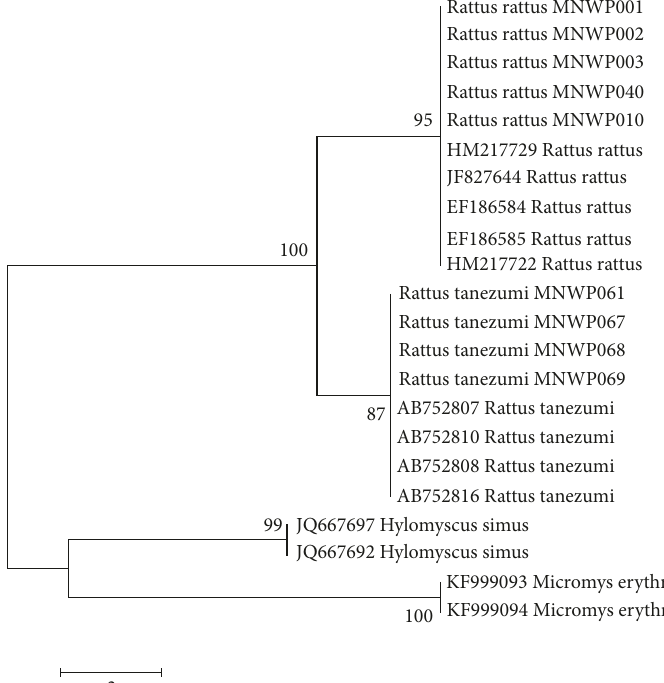
Figure 5: Phylogenetic tree based on distance matrix analysis of COI gene sequences from R. rattus and R. tanezumi based on the Hasegawa- Kishino-Yano model with 1,000 bootstrap support values. The analysis involved 22 nucleotide sequences whereby 9 sequences were derived from this study and the remaining from the NCBI database. All positions containing gaps and missing data were eliminated. There were a total of 598 positions in the final